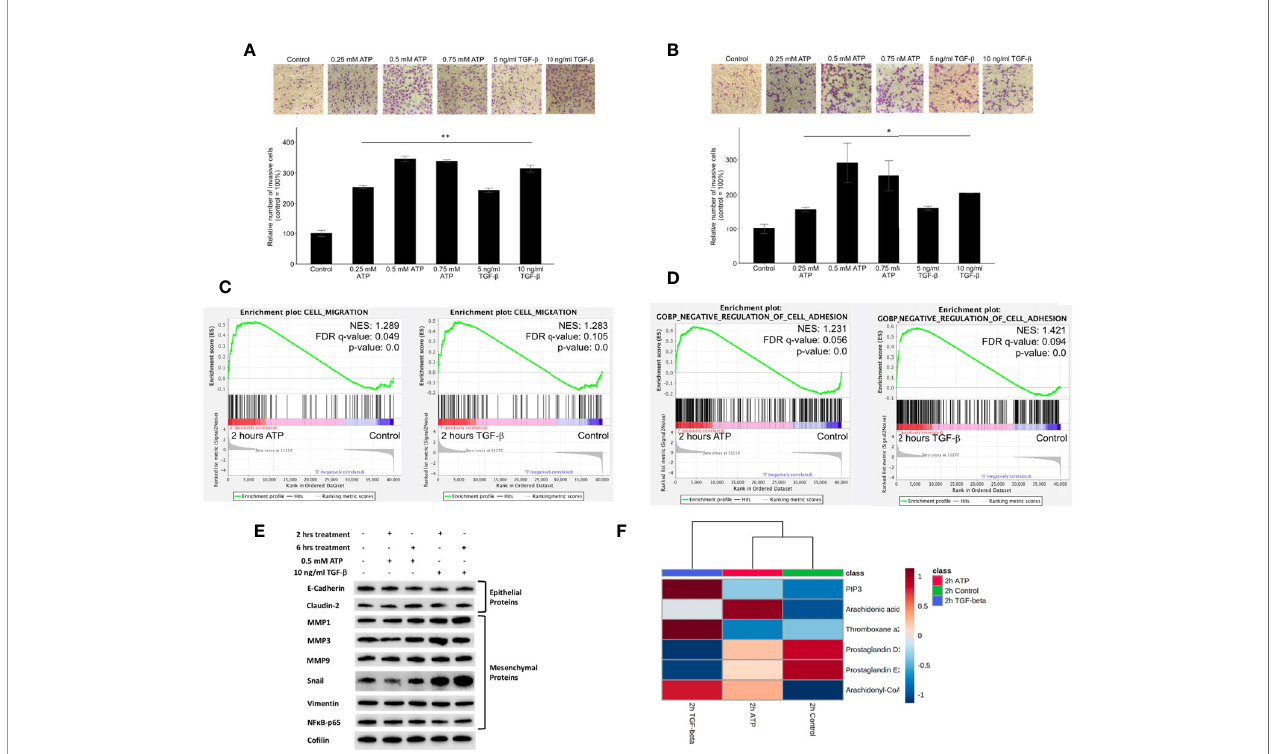
FIGURE 3 | Extracellular ATP induces dose-dependent invasion faster than TGF- b . Human NSCLC A549 and H1299 cells were grown in Transwells with collagen Matrigel coated membranes for 20 hours (invasion assay) in the presence or absence of ATP or TGF- b at various concentrations. After the treatment, invaded cells were fi xed, stained, and visually counted and averaged. RNAseq analysis was used to identify corresponding gene expression changes. GSEA plots for the “ cell migration ” and “ negative regulation of cell adhesion ” signatures were performed to match/verify the observed phenotypic changes. NES: normalized enrichment score. *P < 0.05, **P < 0.01. (A, B) eATP and TGF- b induce cell invasion in A549 cells (A) and in H1299 cells (B, C) GSEA plots, 2 hours ATP compared to control (left) and 2 hours TGF- b compared to control (right). (D) GSEA plots for the “ Negative regulation of cell adhesion ” signature, 2 hours ATP compared to control (top) and 2 hours TGF- b compared to control (bottom). (E) Western blot analysis of selected proteins related to EMT. Co fi lin served as a loading control. The quanti fi cation of these proteins can be found in the Supplemental Figure S3 . (F) Metabolomics heatmap for 6 metabolites involved in cell migration in differently treated